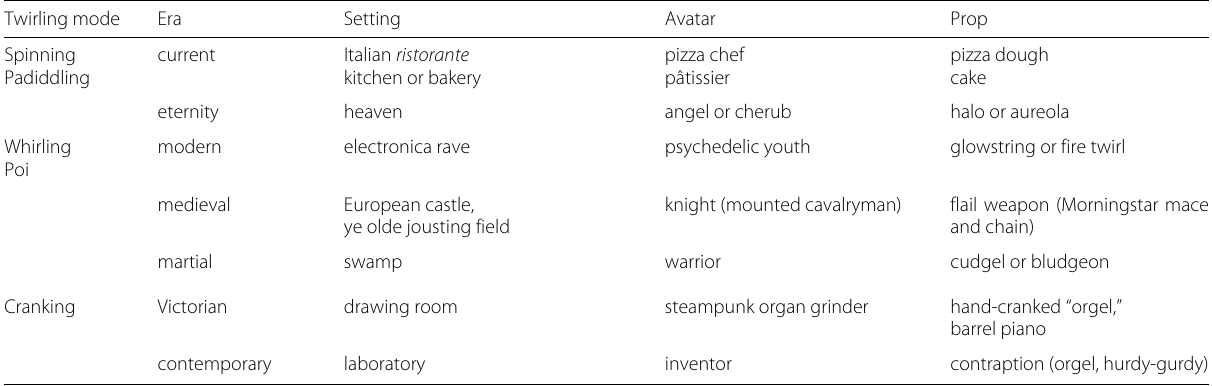
Table 4 Augmented virtuality scenes, rigged for twirling affordance adaptive projection Twirling mode